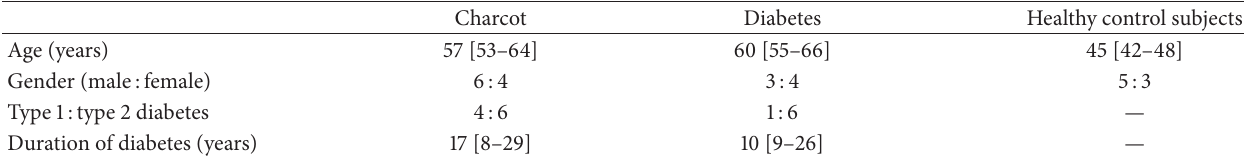
Table 1: Demographic features of the study